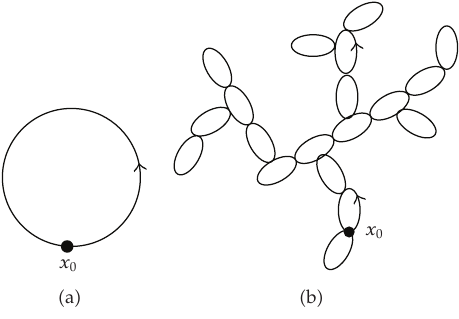
Figure 2: Loop vertices and a tree on them, or